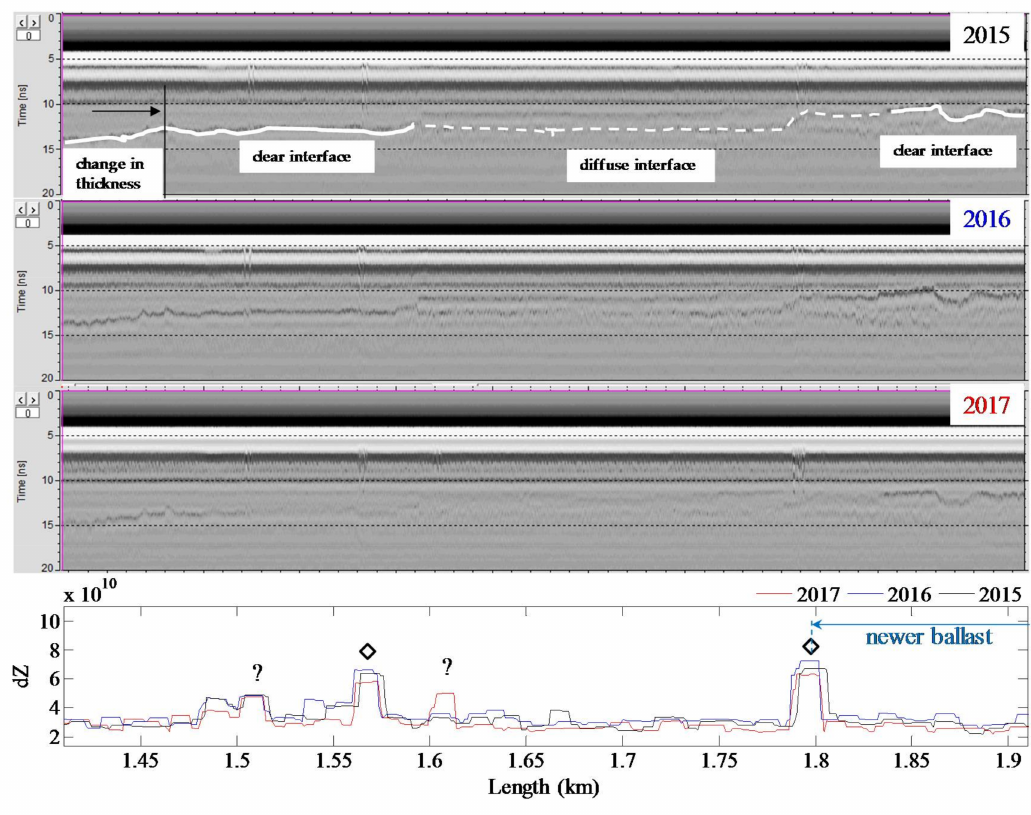
Figure 15. GPR radargrams of the surveys carried out in the summers of 2015, 2016 and 2017 as well as respective dZ